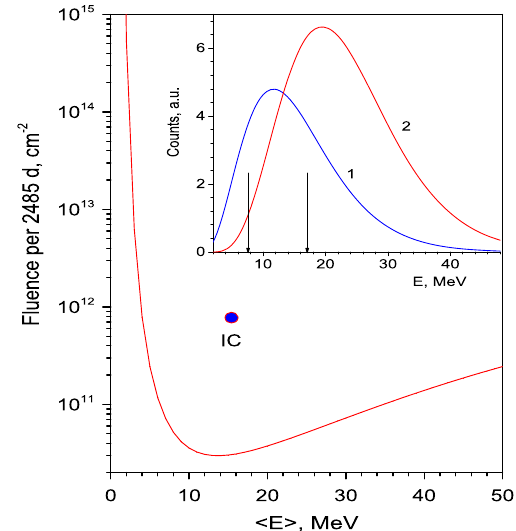
Fig. 9 Upper limits on the fluences of monoenergetic ¯ ν e (90% C.L.). The inset shows the Borexino spectrum of ¯ ν e -like events [29]